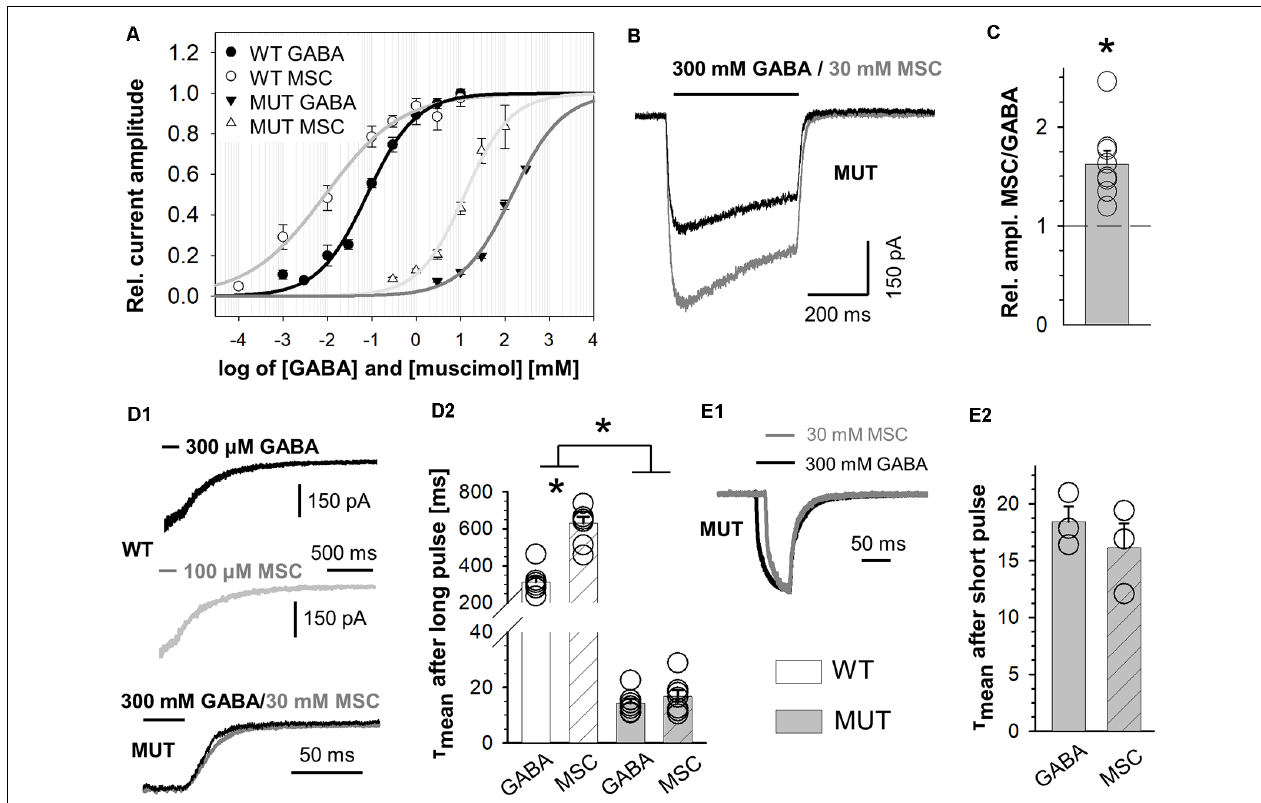
FIGURE 3 | The impact of β 2 E155C mutation on kinetics of muscimol (MSC)-evoked macroscopic currents. (A) Dose–response relationships with fitted Hill’s equation for α 1 β 2 γ 2 (WT-MSC: EC 50 : 9.0 µ M, n H : 0.50) and α 1 β 2 E155C γ 2 (MUT-MSC: EC 50 : 12.5 mM, n H : 0.84) GABA A Rs (GABA—black symbols and MSC—white symbols). Note that the mutation strongly right shifted the dose–responses for GABA, while for MSC, the shift was qualitatively similar, considering that the dose–response for MSC shows a leftward shift with respect to that for GABA both for WT and for mutated receptors. (B) Typical traces of current responses mediated by MUT receptors evoked by long pulses of 300 mM GABA (black) and 100 mM MSC (gray) measured from the same cell. (C) Statistics of relative amplitudes (MSC/GABA) for mutated receptors. Each point on the plot represents recordings made from the same cell. Note that in spite of a similar potency of MSC and GABA, the former agonist evokes currents with absolute amplitude larger by nearly 50% than in the case of GABA. (D,E) The impact of β 2 E155C mutation on deactivation kinetics after prolonged (D) and short (E) application of agonists (for WT: 300 µ M GABA and 100 µ M MSC). (D1,E1) Typical traces showing deactivation phases of current responses to 500-ms agonist application (D1) or to short (few ms) pulses of these ligands (E1) . Currents evoked by GABA are drawn with a black line, whereas those for MSC with a gray one. (D2,E2) Statistics for the mean deactivation time constant ( τ mean ) after long (D2) and short (E2) pulses of MSC (crosshatch) or GABA (unfilled). In the statistics graphs (D2,E2) , bars referring to WT receptors are white, and those describing mutants are gray. Note that β 2 E155C mutation abolishes differences between deactivation kinetics for currents evoked by GABA and MSC. Asterisks indicate a statistically significant difference.